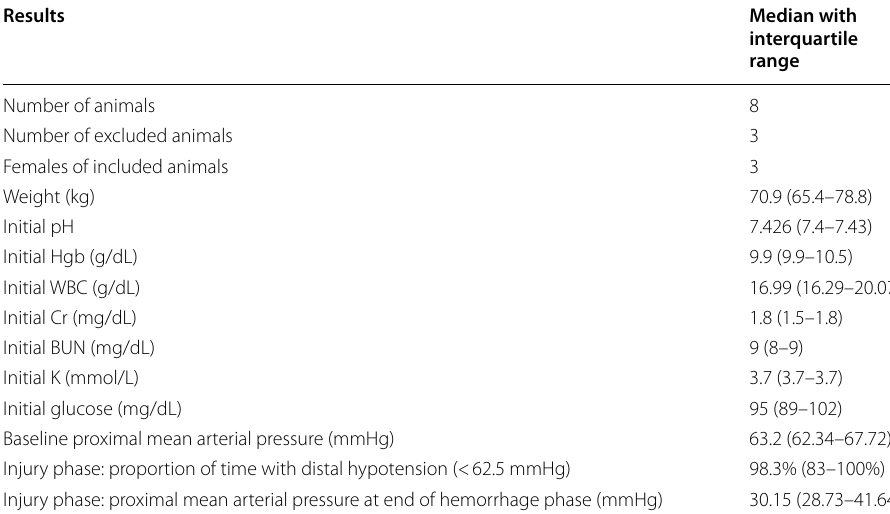
Table 1 Baseline characteristics and injury metrics Results Median with